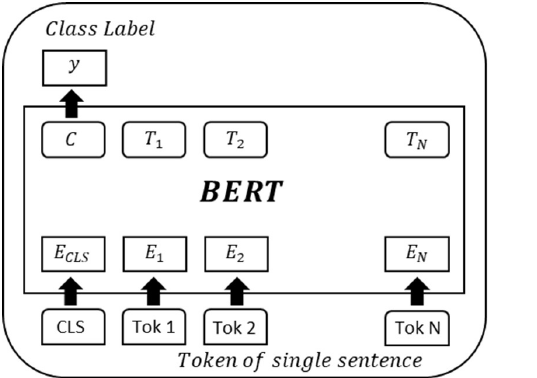
Figure 2. Illustrations of fine-tuning BERT for classification tasks (from Figure 4(b) in [18]) where each news (input) contains N tokens (words), and the output is a predicted class label y